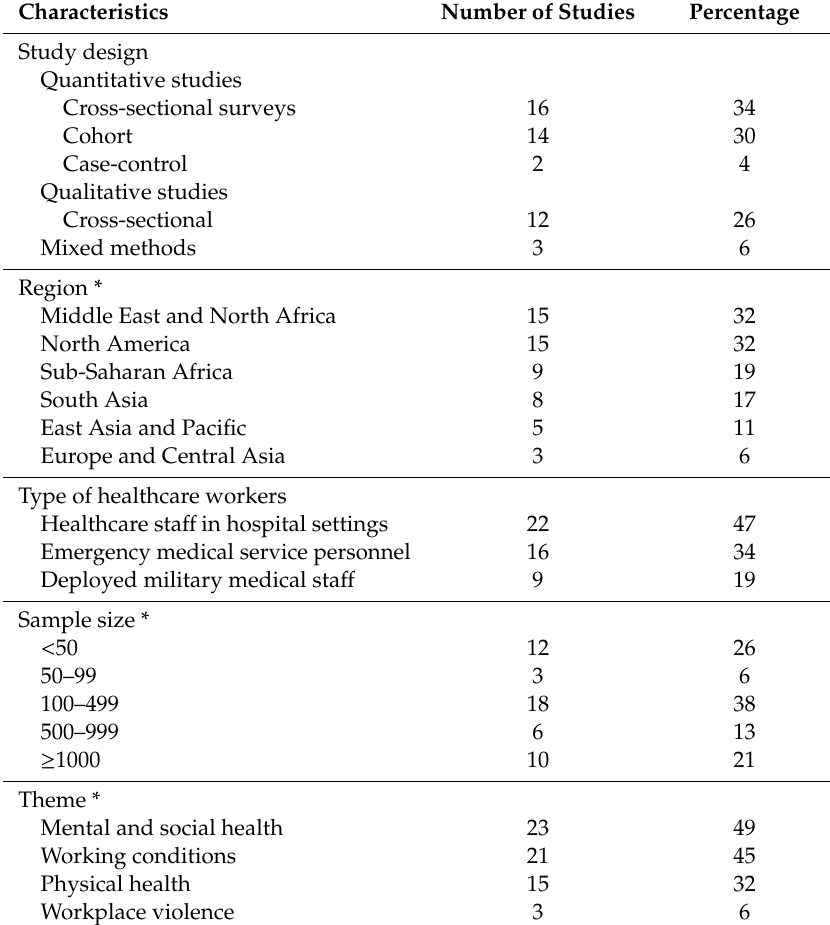
Table 1. Descriptive characteristics of the included articles (n =